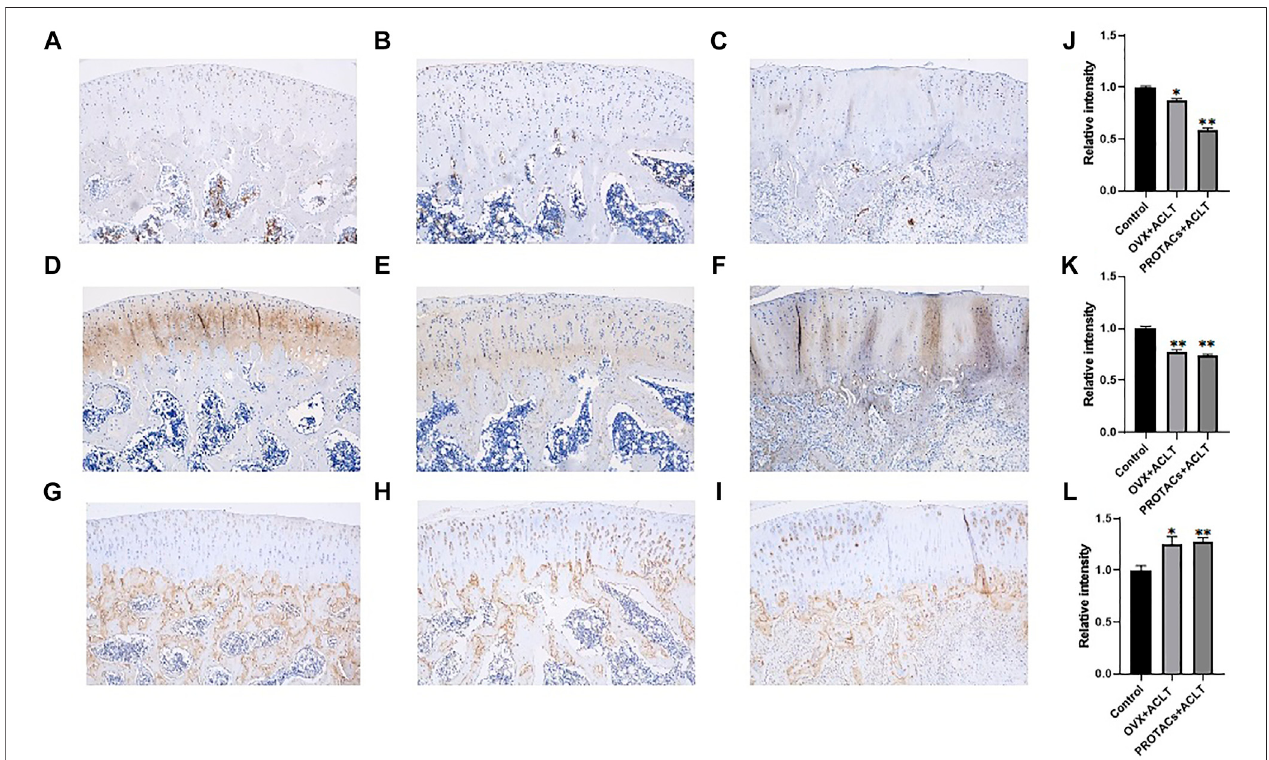
FIGURE5| Representativeimmunohistochemicalstainingimagesofcartilagetissuesinthedifferenttreatmentgroups.Scalebars,250 μ m.Eachgroupcontained 3 rats, and similar results were obtained in all rats. Anti-ER α immunohistochemical staining of (A) Control group, (B) OVX + ACLT, (C) PROTACs + ACLT. Anti-COL2 immunohistochemicalstainingof (D) controlgroup, (E) OVX+ACLT, (F) PROTACs+ACLT.Anti-MMP-13immunohistochemicalstainingof (G) controlgroup, (H) OVX+ ACLT, (I) PROTACs + ACLT. The intensity of immunohistochemical staining of ER α (J) , COL2 (J) , and MMP-13 (L) . The integrated optical density of immunohistochemical staining was quanti fi ed using the Image J